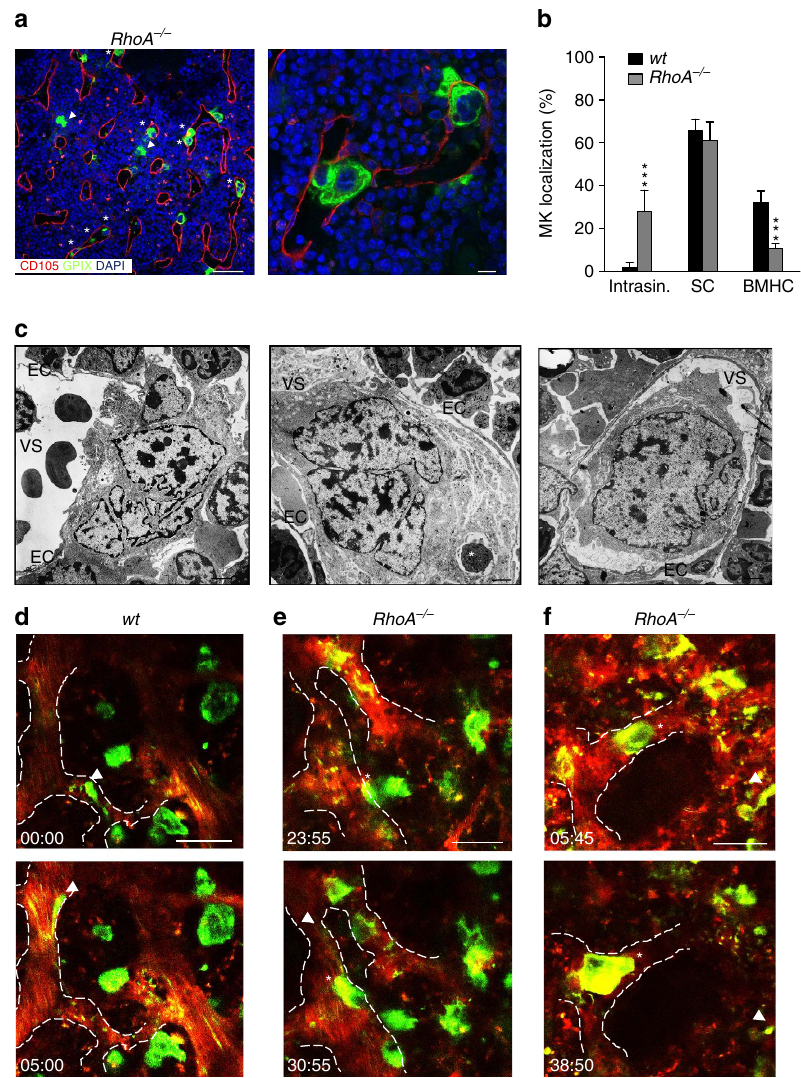
Figure 3 | RhoA negatively regulates MK guidance and transmigration. ( a ) Representative confocal images of immunostained BM of RhoA (cid:2) / (cid:2) mice. Scale bars, 50 m m (left panel); 10 m m (right panel). MKs, proplatelets and platelets are shown by GPIX staining in green. Endoglin staining (red) labels vessels. DAPI, blue. Arrowhead indicates MKs in BMHC, asterisk indicates intrasinusoidal (intrasin.) MKs. ( b ) Quantification of MK localization in the BM reveals abundant intrasinusoidal localization of RhoA (cid:2) / (cid:2) (grey) MKs compared to the wt (black) ( n ¼ 9). ( c ) TEM analysis of RhoA (cid:2) / (cid:2) BM MKs. Scale bars, 2.5 m m. EC, endothelial cell; VS, vascular sinus. Asterisk indicates emperipolesis ( n ¼ 6 (wt) and 8 ( RhoA (cid:2) / (cid:2) )). ( d – f ) Intravital two-photon microscopy of wt ( d ) and RhoA (cid:2) / (cid:2) ( e , f ) BM MKs in the skull. Arrowhead indicates proplatelet formation, asterisk indicates intrasinusoidal MKs ( n ¼ 7 and 6). Scale bars, 50 m m. Bar graphs represent mean ± s.d. Two-way ANOVA with Bonferroni correction for multiple comparisons; *** P o